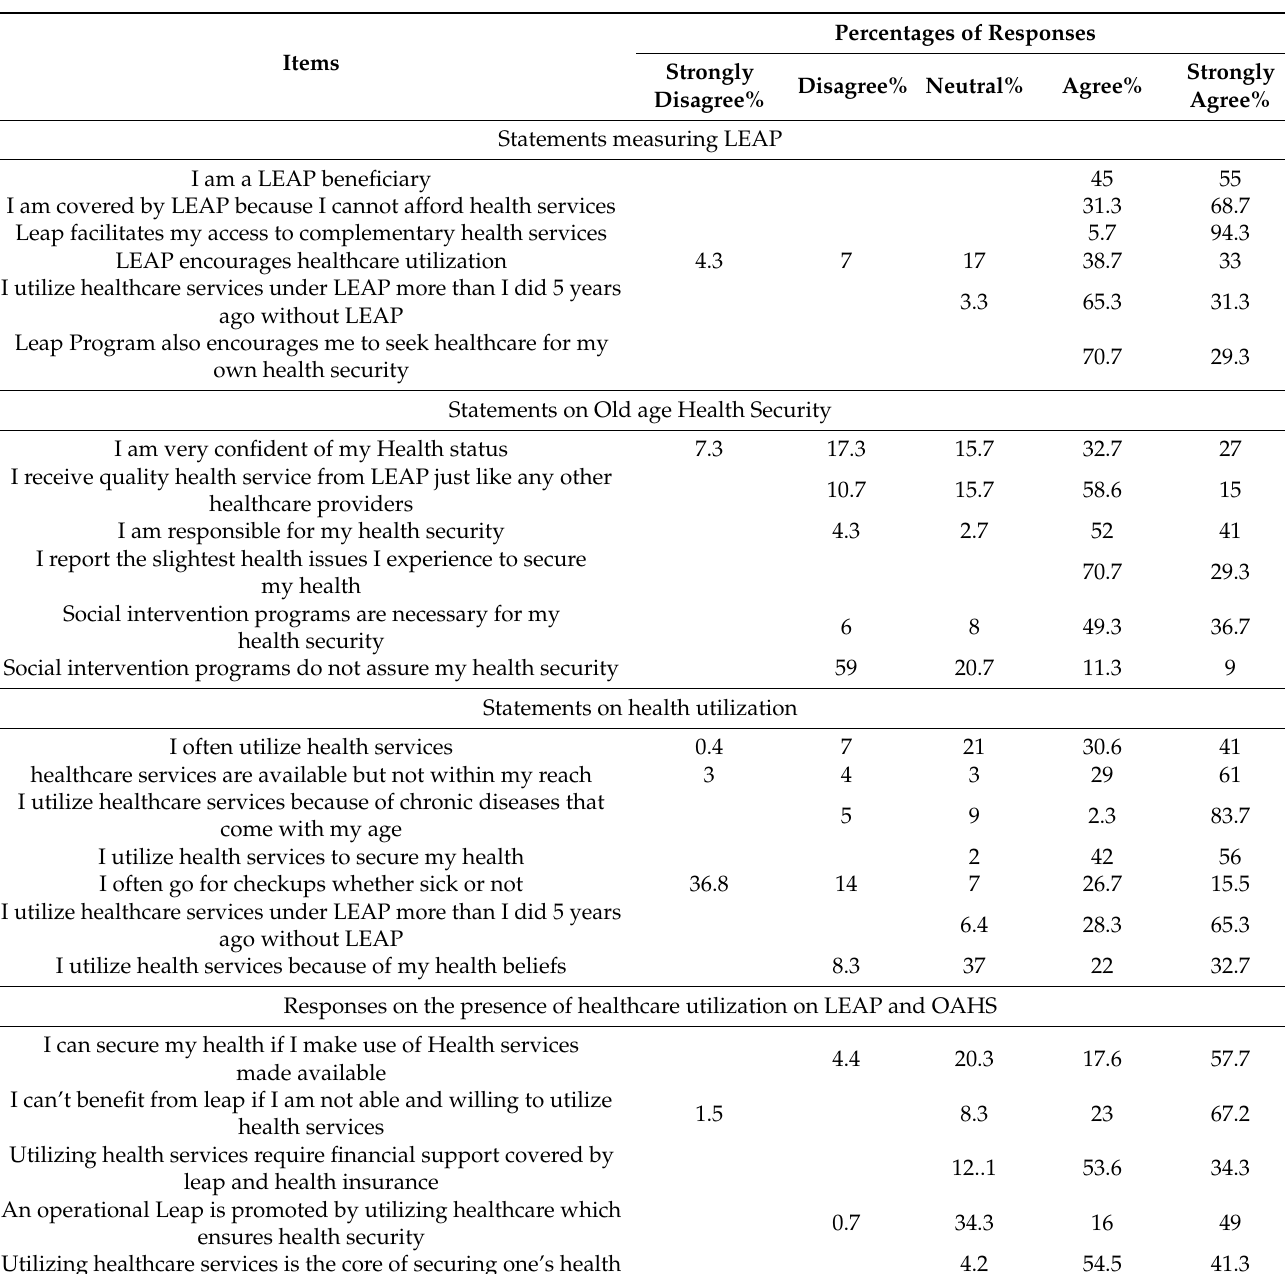
Table A1. Questionnaire items and responses related to LEAP, HU and